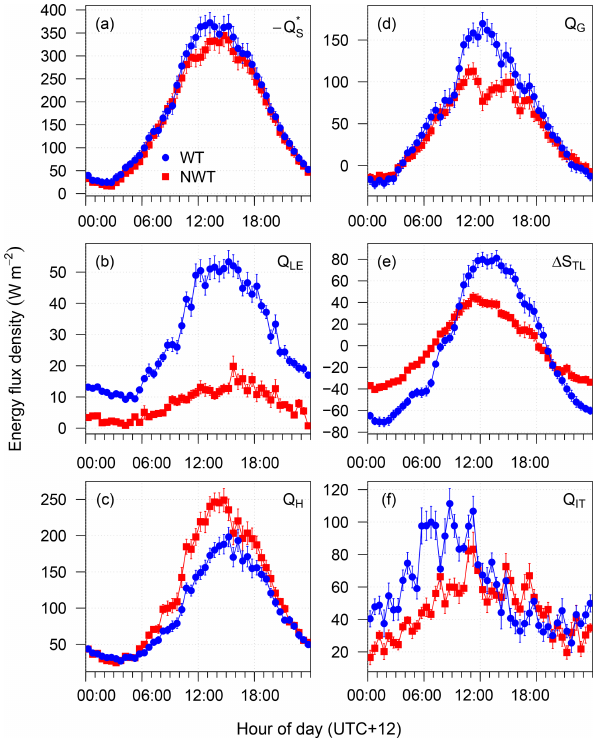
Figure 5. Comparison of diurnal variations in inverted net radia- (a) , latent evaporative heat flux Q LE (b) , sensible heat tion − Q ∗ S flux Q H (c) , ground heat flux Q G (d) , energy storage change in the thawed layer (cid:49)S TL (e) , and soil heat flux at ice table depth Q IT (f) between WT (water track) and NWT (non-water track), averaged over the entire measuring period of 26d. Energy fluxes for (a) and negative energy fluxes for (d) are directed towards the ground sur- face; energy fluxes for (b) – (d) and (f) and positive energy fluxes for (d) point away from the ground surface. Positive energy fluxes for (e) are directed from the ground surface or the ice table into the thawed layer and negative fluxes move out of the thawed layer to- wards the ground surface or the ice table. Error bars depict standard errors of the